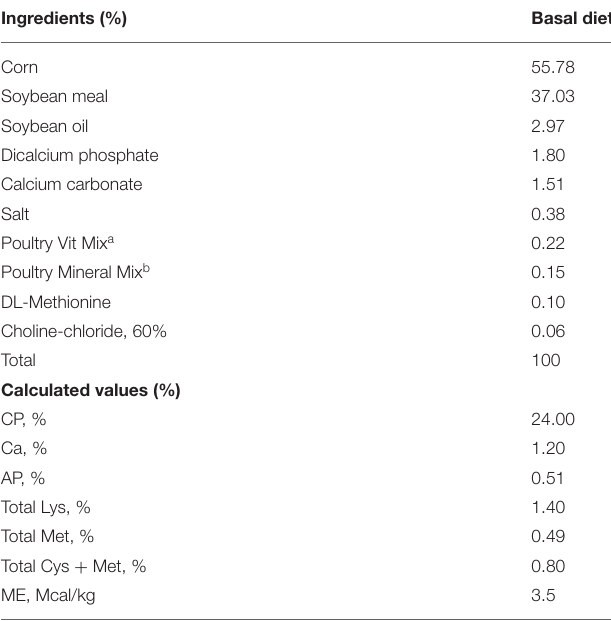
TABLE 2 | Ingredient composition of basal diet (as feed? basis, %, unless otherwise